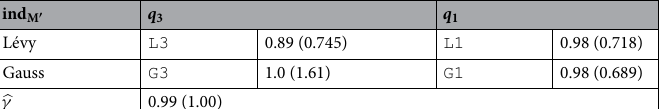
Table 3. Comparison of the error, ind M ′ ( M ′ = 30,000 ) , for various estimators in identical twin experiment. Lévy/Gaussian indicates the generator used in cascade model simulation. Here, q 3 / q 1 indicates whether joint PDF or marginal PDF is used as the density generated by the cascade model simulation; arithmetic mean. Each number in parentheses is the prefactor a for the corresponding estimator.